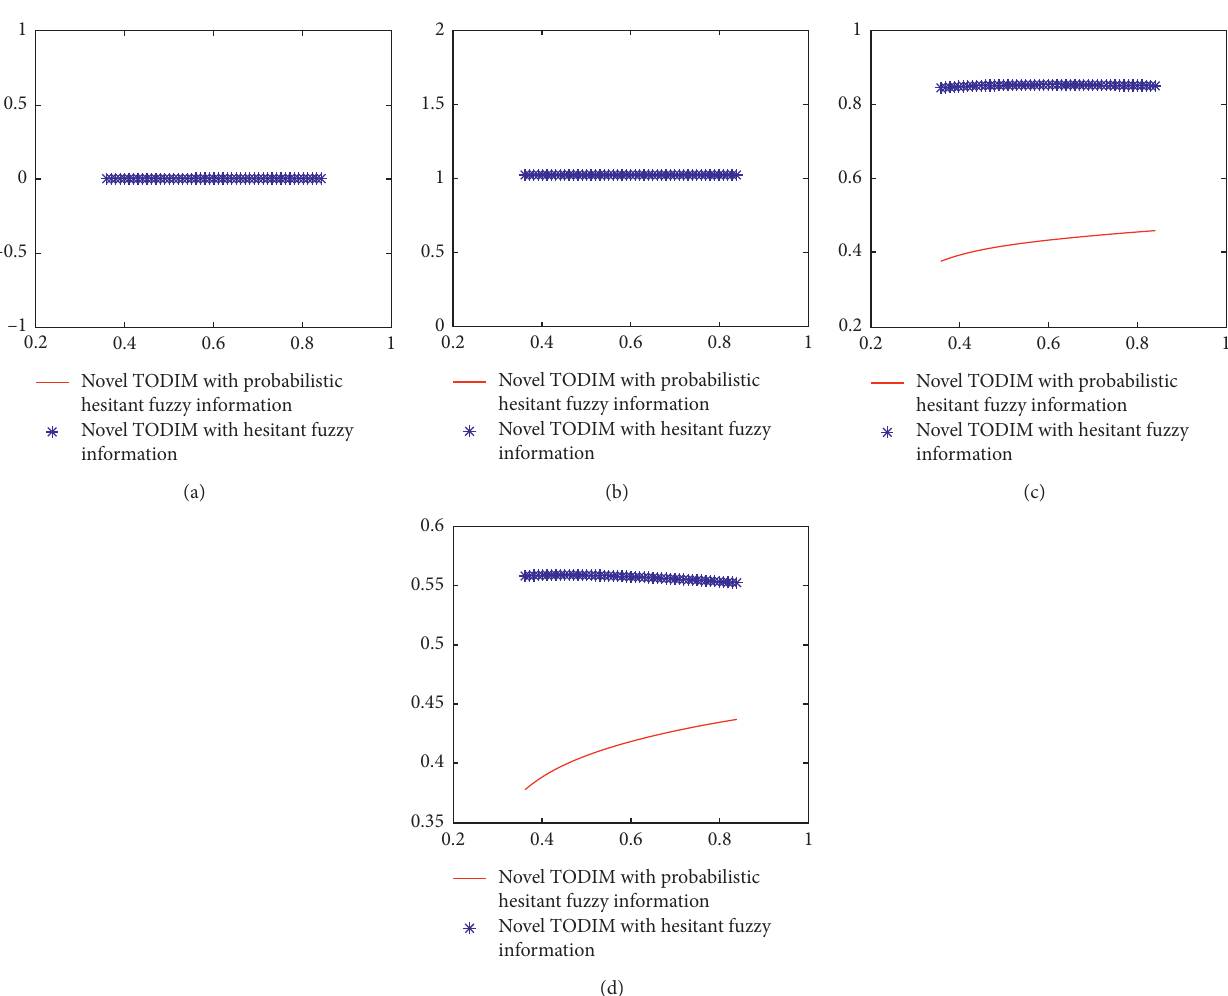
1 ; (b) A 2 ; (c) A 3 ; (d) A 4